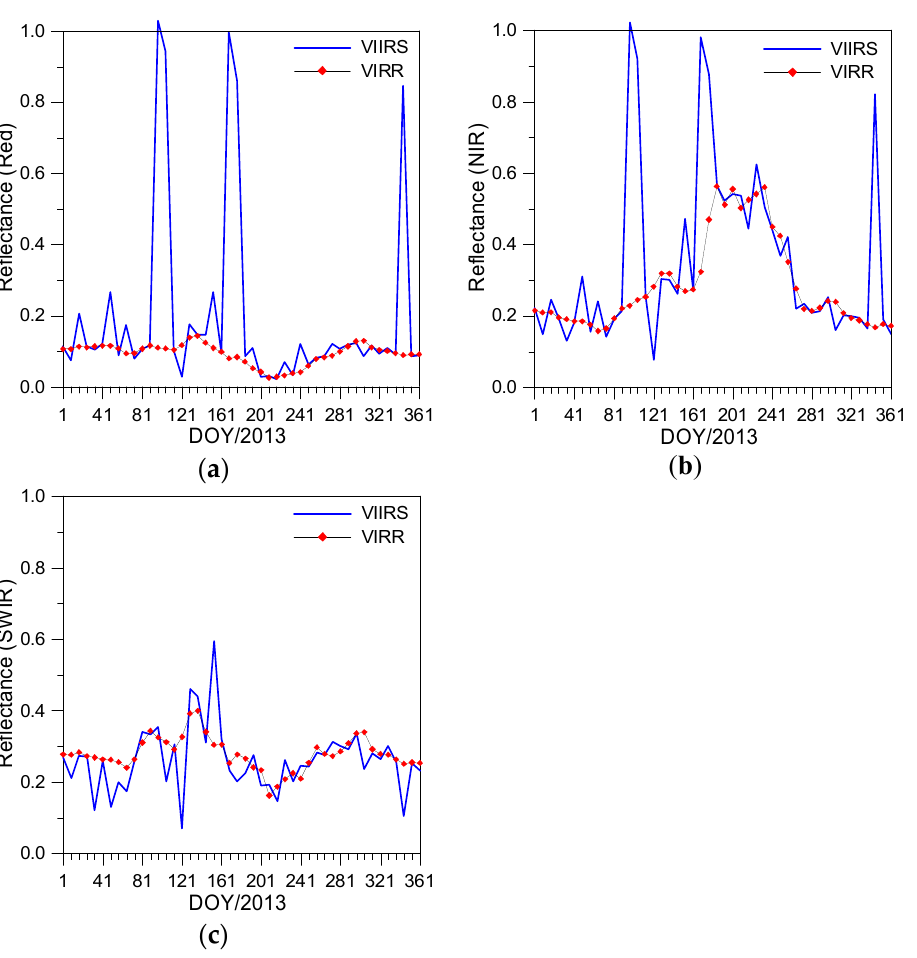
Figure 2. Temporal profiles of VIIRS surface reflectance and reconstructed surface reflectance using the VIRR method for the center pixel of the AGRO site in 2013. ( a ) Surface reflectance in the red band; ( b ) surface reflectance in the NIR band; ( c ) surface reflectance in the SWIR band. Table 3. Similarities (%) between the series of the VIIRS and GLASS, MODC5 and MODC6 LAI/FAPAR values and the series of the reconstructed VIIRS and MODIS surface reflectance